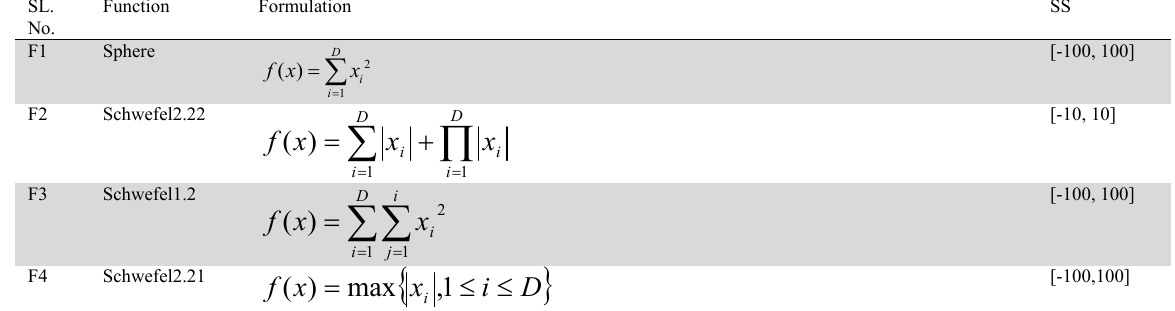
Function used for checking the validity of the proposed method, SS: Search Space, D: Dimension=50, fmin=0 SL.